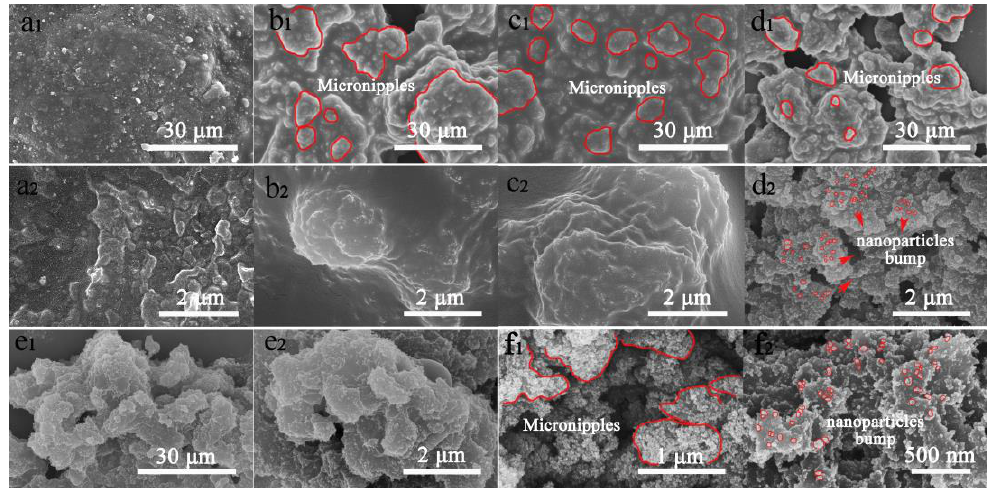
Figure 8. SEM image of fluorinated epoxy coating with different proportions of micro- and nano-silica (The mass ratio of nano-silica and micro-silica particles: ( a 1 , a 2 ) 0:1, ( b 1 , b 2 ) 1:0, ( c 1 , c 2 ) 2:1, ( d 1 , d 2 ) 1:2, ( e 1 , e 2 ) 1:1 and ( f 1 , f 2 ) 1:1 energy-dispersive X-ray spectroscopy (EDS) and X-ray photoelectron spectroscopy (XPS) were used to analyze the chemical composition of the FEP-S coating. C, O, F, and Si were detected in the EDS mapping shown in Figure 9; all elements were uniformly distributed.